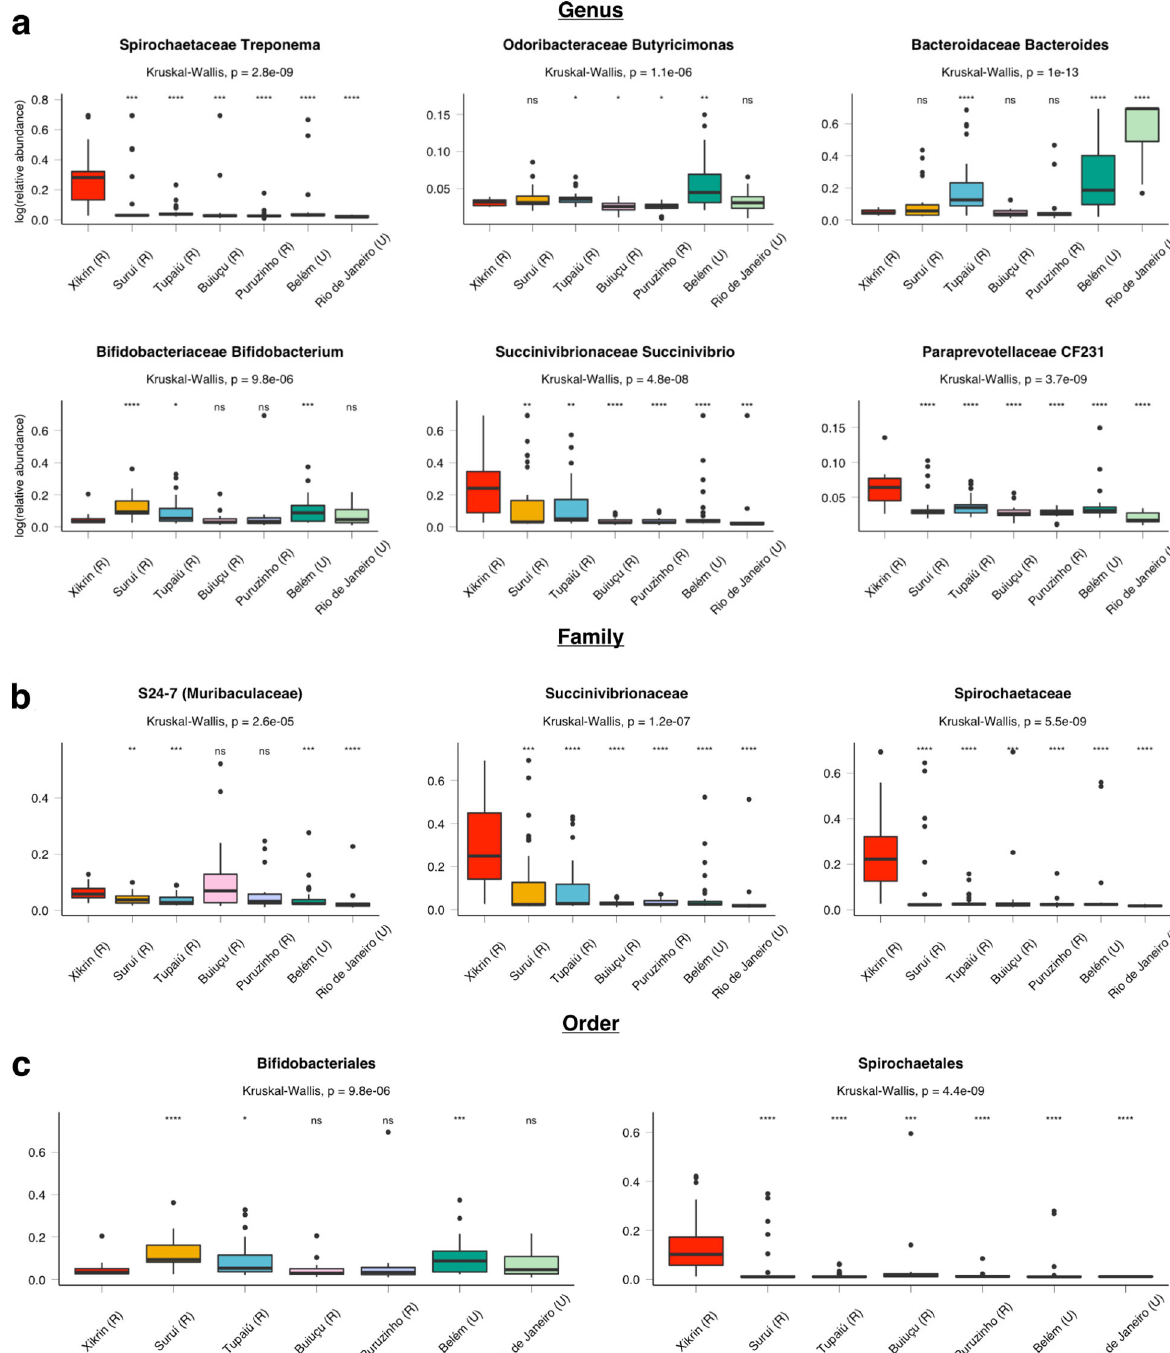
Fig. 4 Differentially abundant taxa among Brazilian populations as determined by ANCOM analyses considering a W > 0.9 cut-off signi fi cance value. a Differentially abundant genera. b Differentially abundant families. c Differentially abundant orders. NS not signi fi